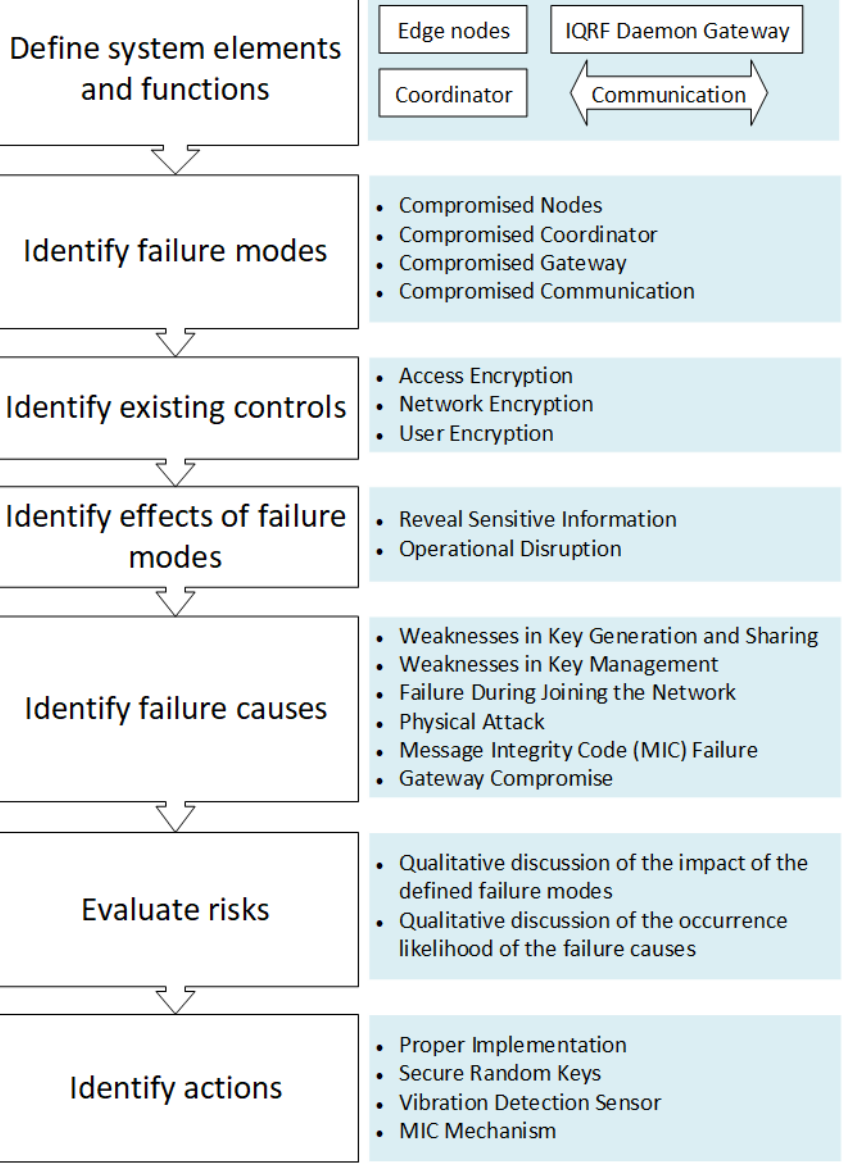
Figure 4. Steps in the FMEA process including the summarized